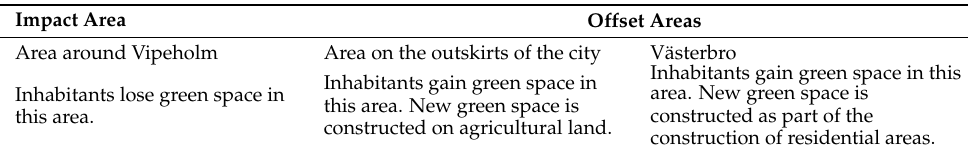
Table 2. Descriptions of the affected areas in our example.